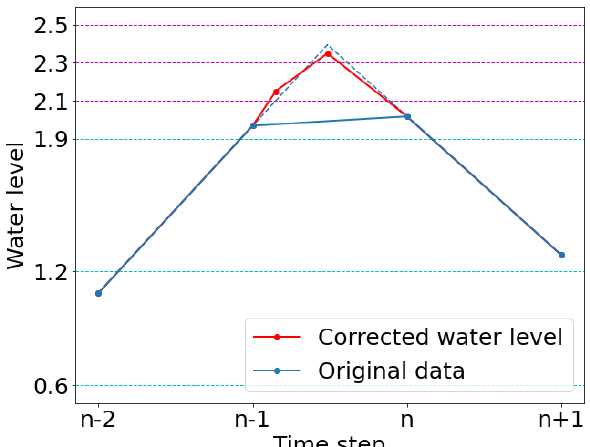
Figure 8. Illustration of case B2: f n − 1 = 1.968 and f n = 2.017 ( with f n − 2 = 1.086 and f n + 1 =